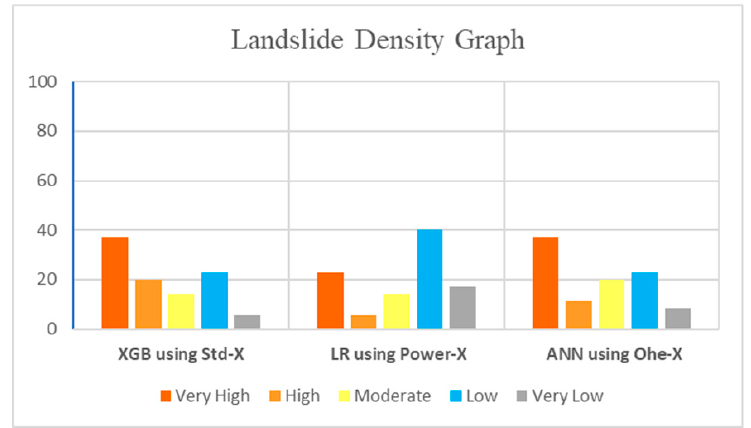
Figure 8. Landslide density graph of the models for XGB using Std-X, LR using Power-X, and ANN using Ohe-X.